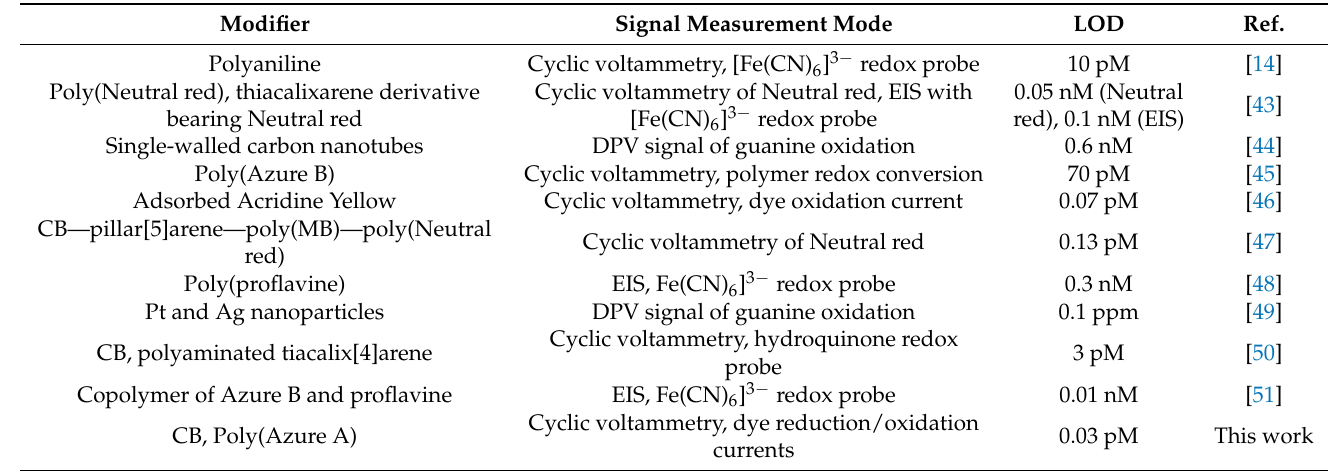
Table 2. Comparison of analytical characteristics of electrochemical DNA sensors for doxorubicin